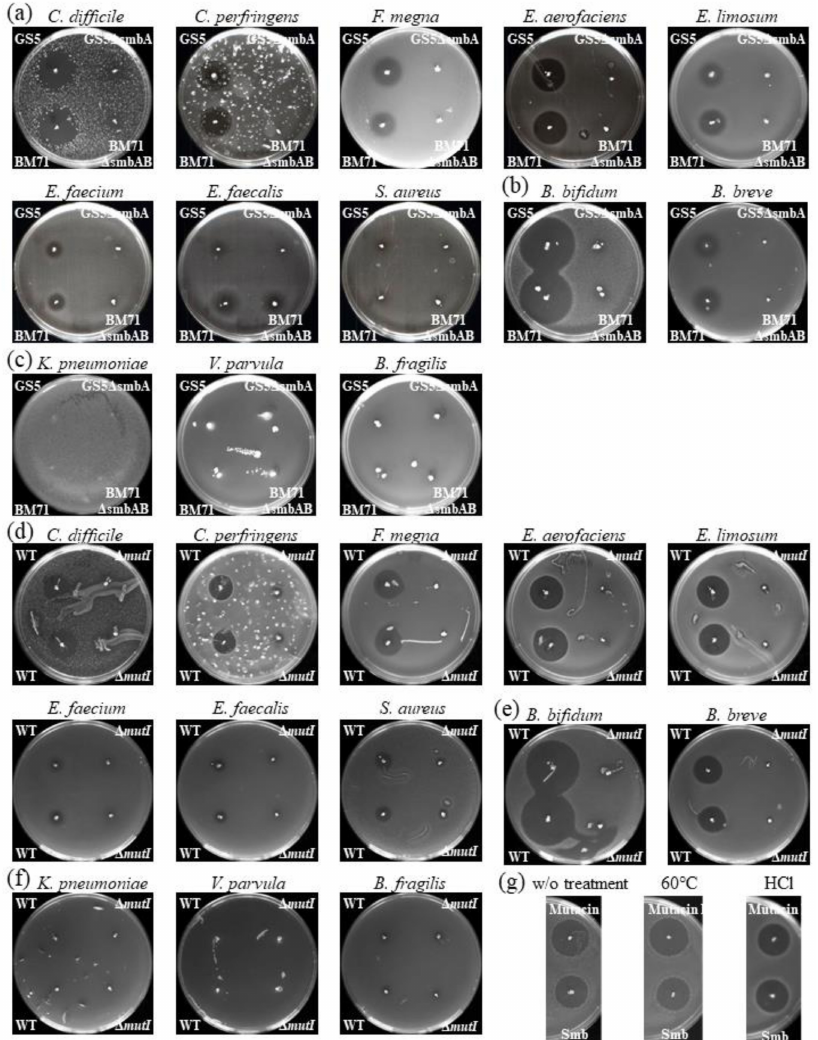
Figure 1. Results of agar plate bacteriocin assay. Smb activity of the producers (GS5, BM71 and its Smb mutant) against intestinal Gram-positive microbiota belonging to phylum Firmicutes ( a ), belonging to phylum Actinobacteria ( b ), or intestinal Gram-negative microbiota ( c ). Mutacin I activity of the clinical isolates against intestinal Gram-positive microbiota belonging to phylum Firmicutes ( d ), belonging to phylum Actinobacteria ( e ), or intestinal Gram-negative microbiota ( f ). Lantibiotic activity after treatment by heating (60 ◦ C for 60 min), or 1N of HCl against F. magna ( g